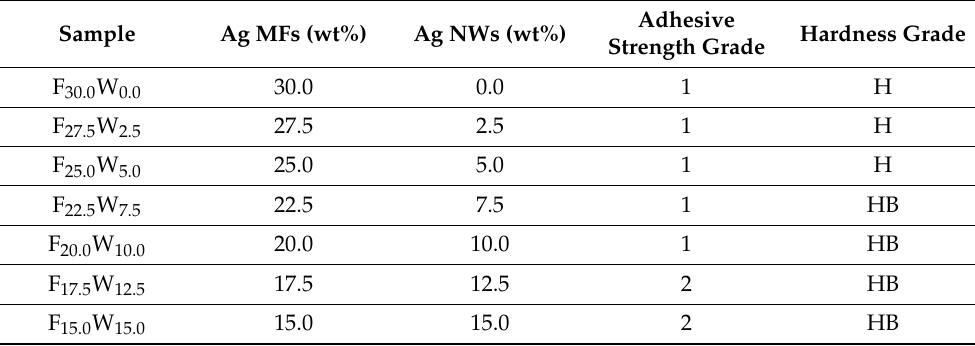
Table 3. Hardness and adhesive strength of silver paste paint films containing different amounts of Ag MFs and Ag NWs after curing at 60 ◦ C. Sample Ag MFs (wt%) Ag NWs (wt%)